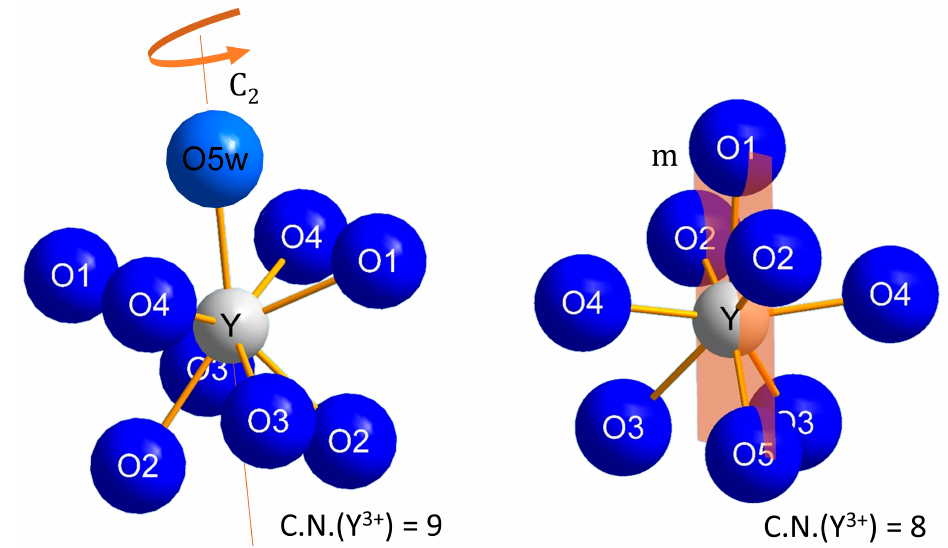
Figure 4. Y 3+ is coordinated by nine oxygen atoms in NaY[SO 4 ] 2 · H 2 O with C 2 symmetry ( left ) and by eight oxygen atoms in NaY[SO 4 ] 2 residing in a mirror plane ( right ).